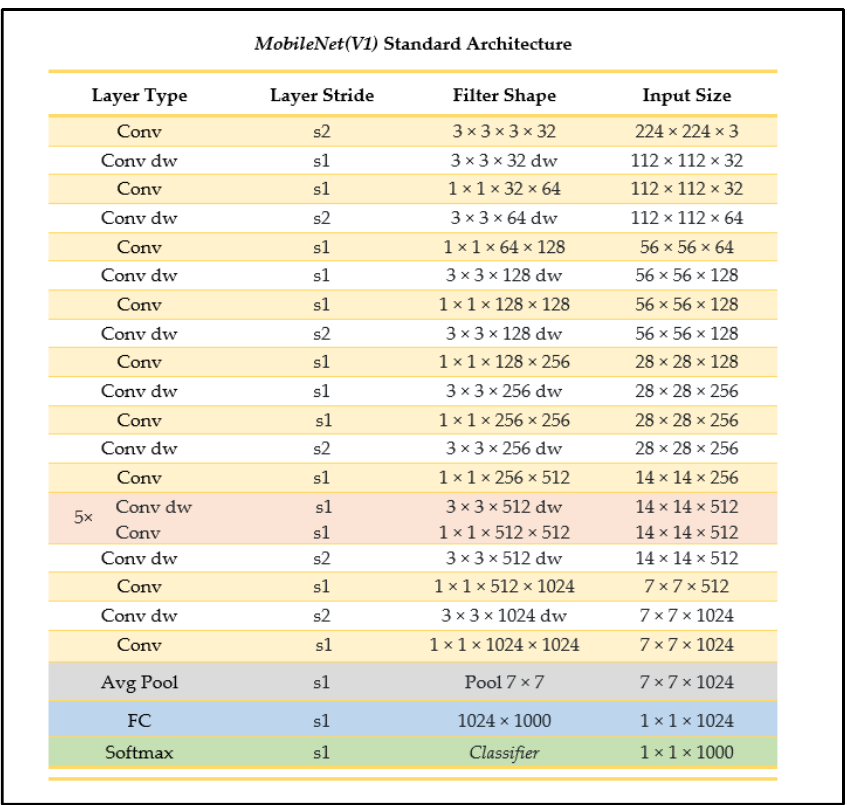
Figure 6. MobileNet standard architecture (as outlined in [24]).